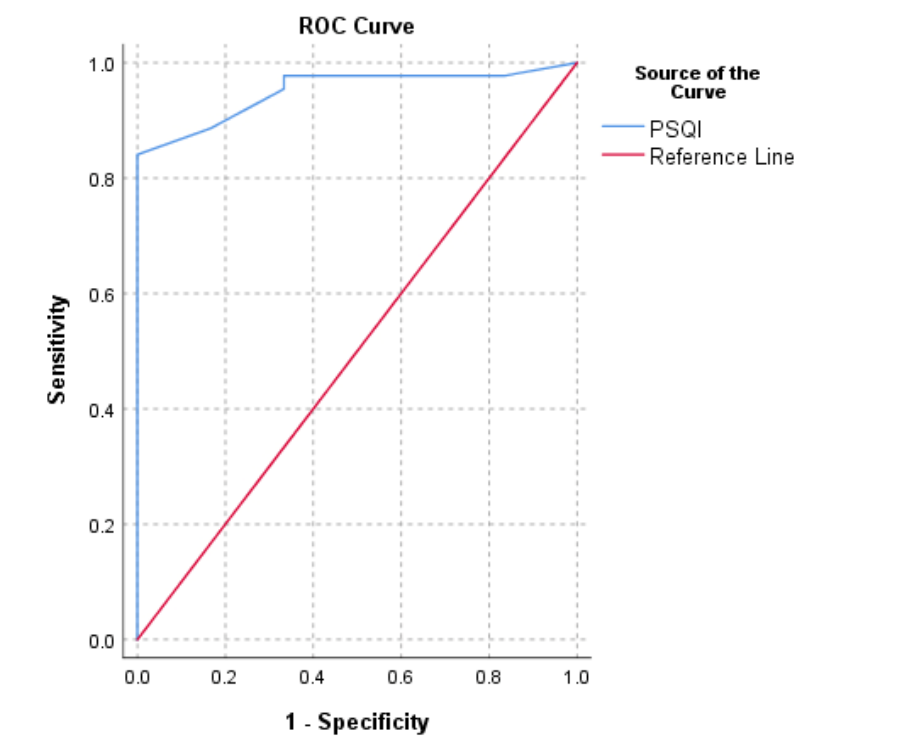
Figure 2. Receiver operating characteristic curve (ROC) for the prediction of PSQI’s patient acceptable symptom state (PASS) based on the question “In general, would you say that your health is at least good?”.